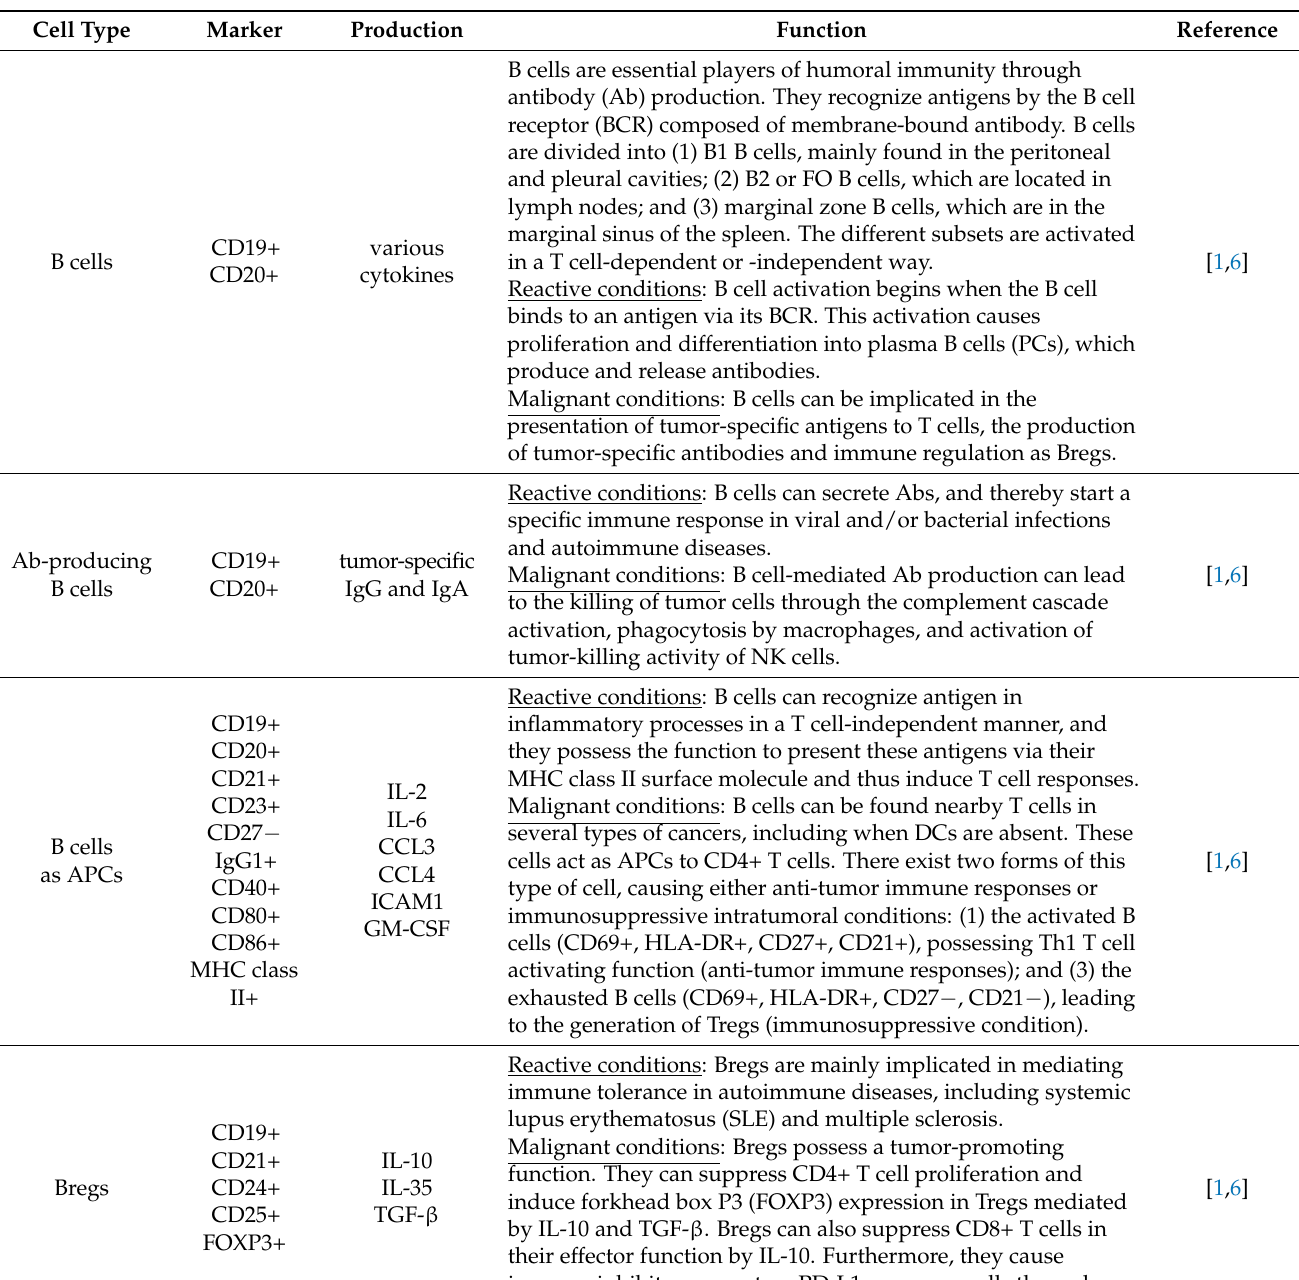
Table 3. Cells of the adaptive immune system in TME: B cell